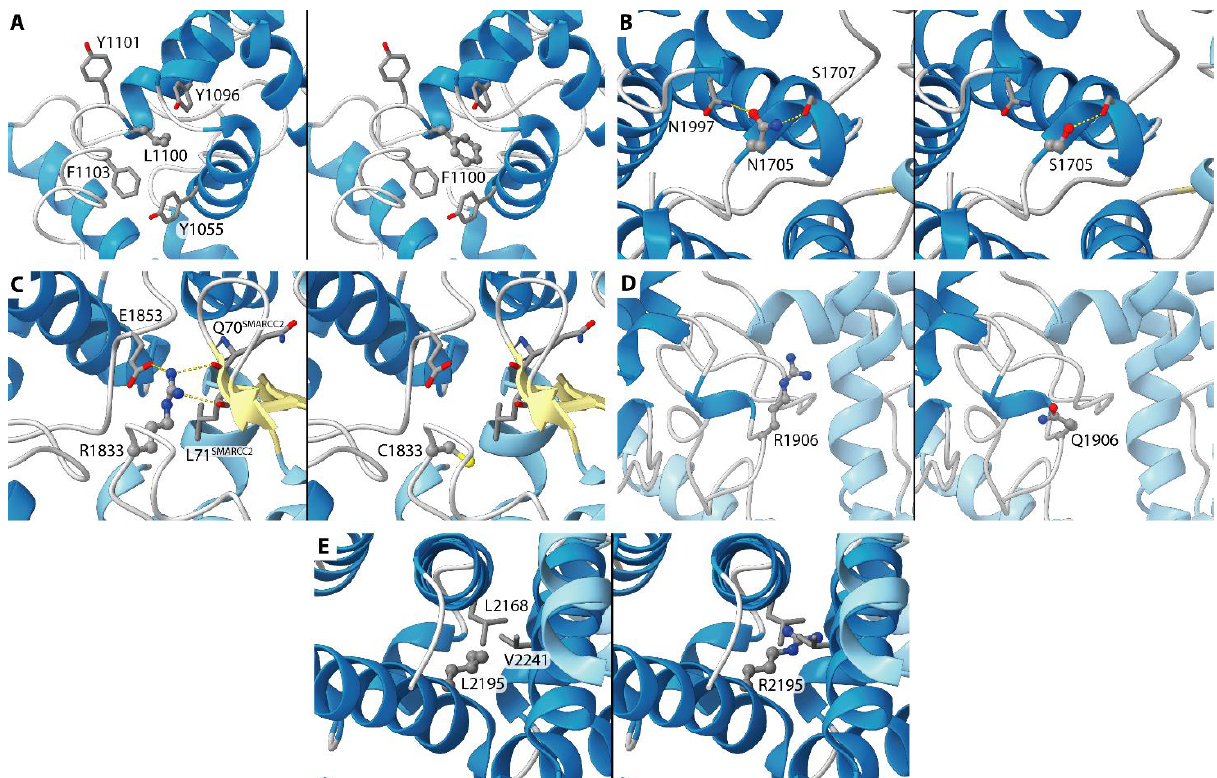
Figure 4. Details of ARID1A Leu1100 ( A ), Asn1705 ( B ), Arg1833 ( C ), Arg1906 ( D ), and Leu2195 ( E ) and of the neighboring residues in the available structures. In each panel, the wildtype structure and the mutant calculated in silico have been reported on the left and on the right, respectively. ARID1A helices are in blue, while helices and strands from other SWI/SNF subunits are in light blue and in light yellow. The considered residue is in ball-and-stick representation while the residues in the vicinity are in sticks. The atoms are colored according to the atom type. The hydrogen bonds have been highlighted by using yellow dashed lines.